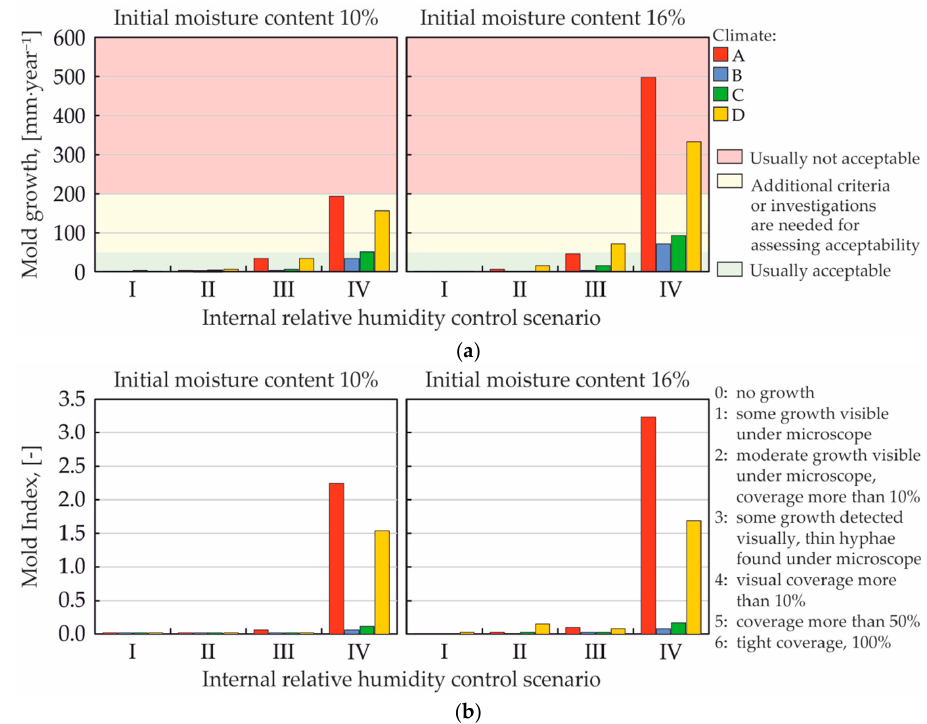
Figure 13. Predicted risk of mold contamination for wooden partition layers depending on the external climate and RH control scenario (ACH = 3 h − 1 ): mold growth ( a ), mold Index ( b ).